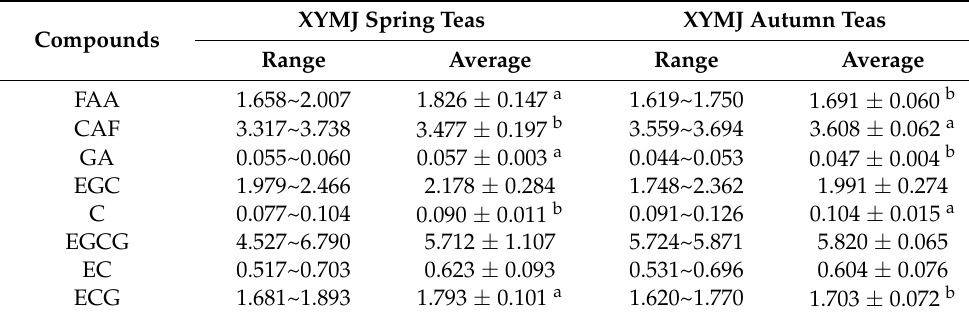
Table 1. Contents of non-volatile compounds in XYMJ green teas